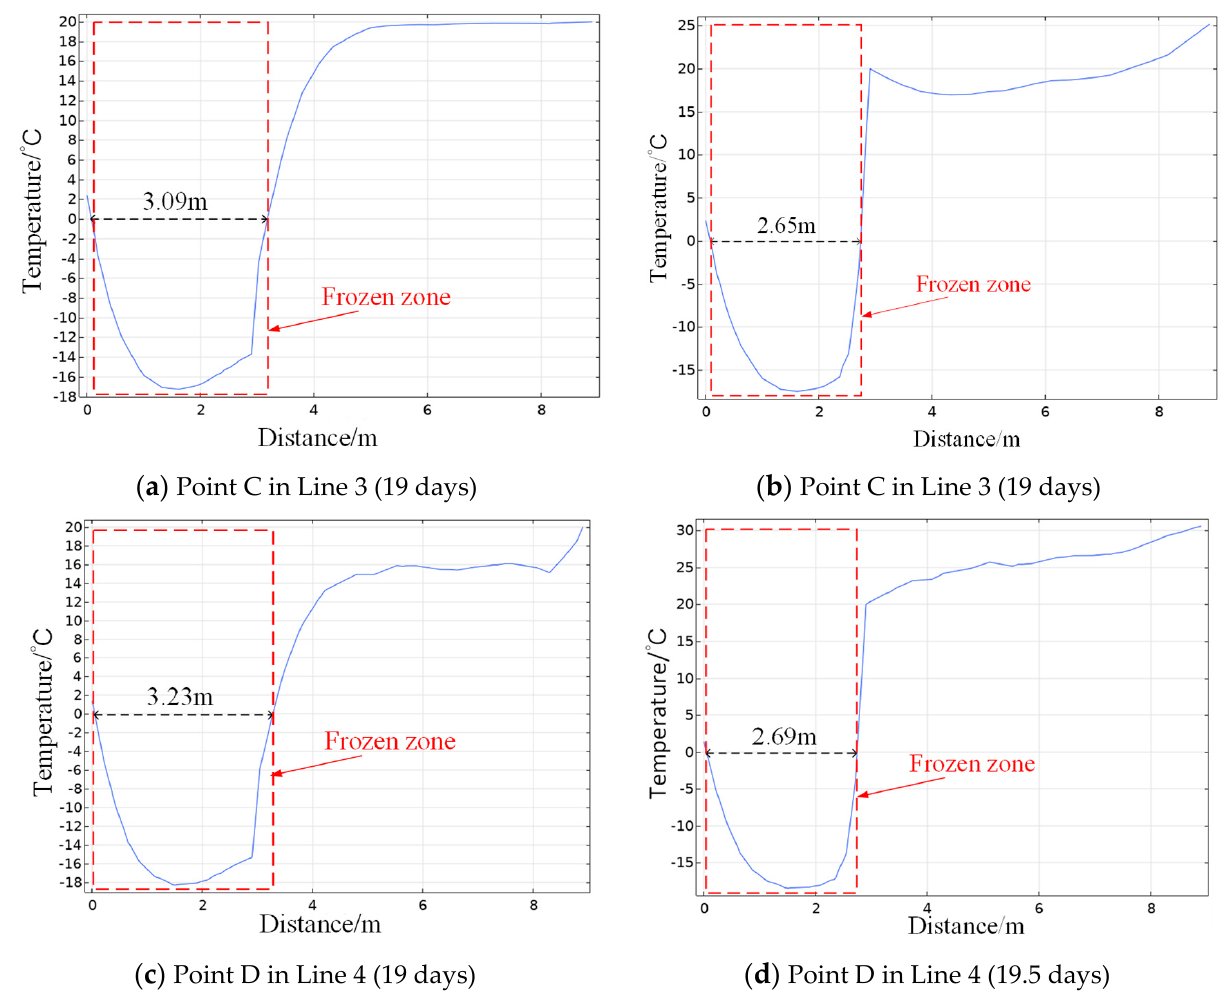
Figure 10. Temperature cloud map in Section 1.